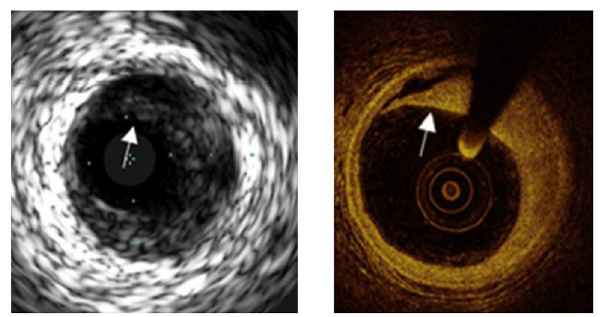
FIGURE 2 | A comparison of images obtained by IVUS and OCT from the same location. The superior resolution of OCT easily permits detection of a dissection (shown by arrows) less apparent by